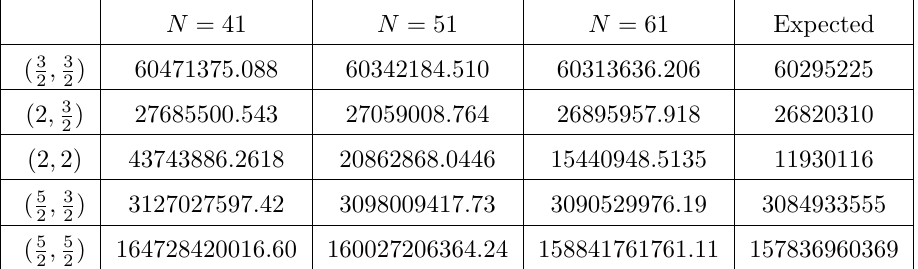
Table 4 . The maximum value of degeneracies for low-lying states in a putative N = (1 ; 1) CFT at c = 33 . 2